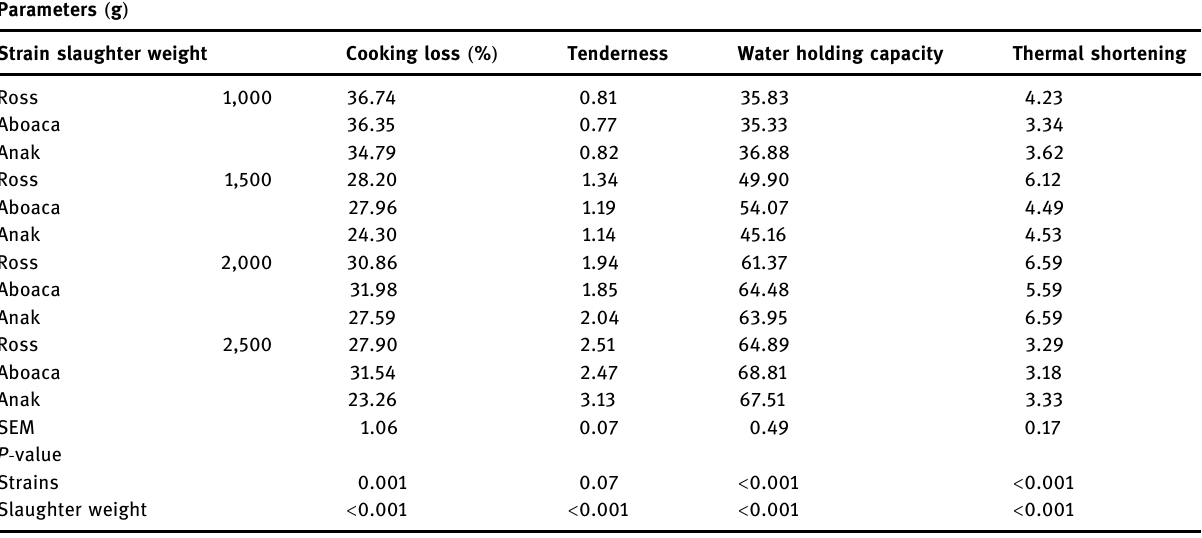
Slaughter weight